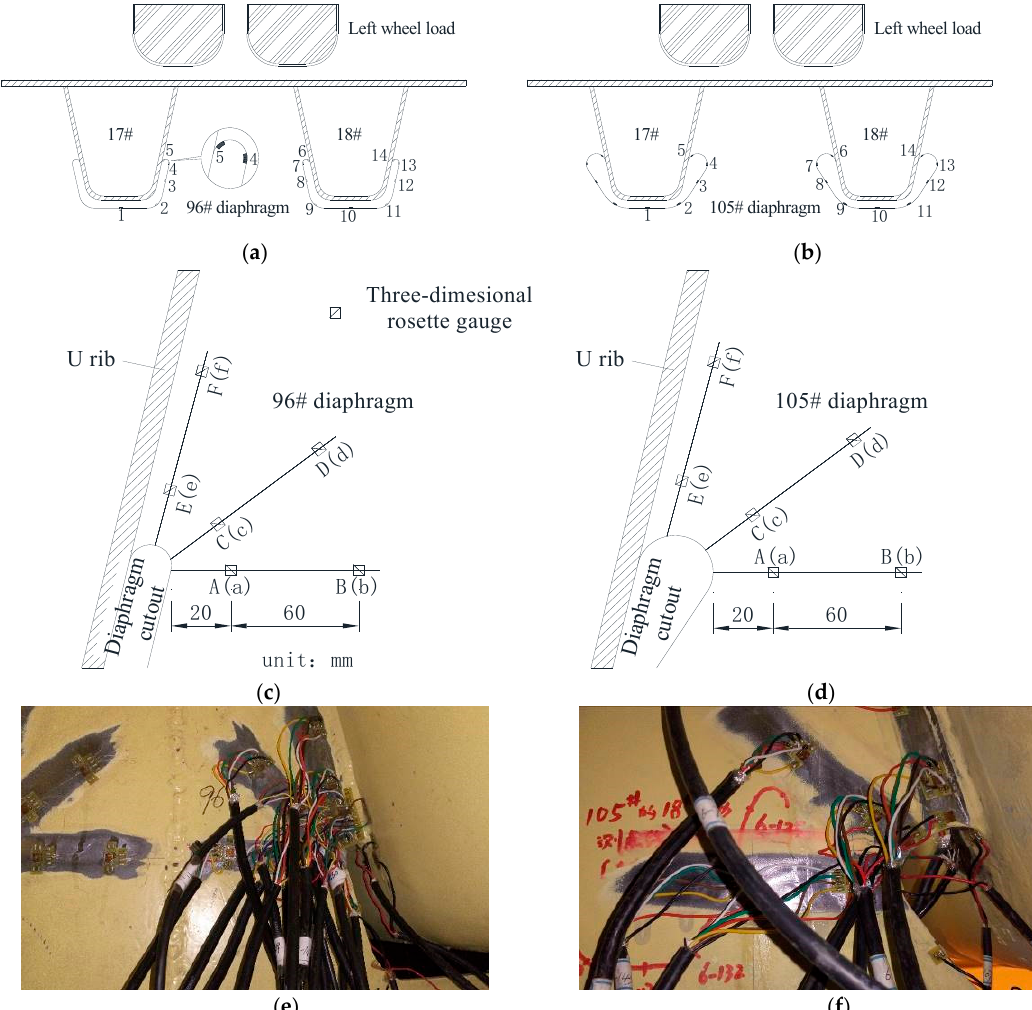
Figure 15. Strain gauges arranged at the section of cutout ( a ) before rehabilitation; ( b ) after rehabilitation. Strain gauges arranged at the side of the diaphragm ( c ) before rehabilitation; ( d ) after rehabilitation. On-site strain gauge arrangement ( e ) before rehabilitation; ( f ) after rehabilitation.